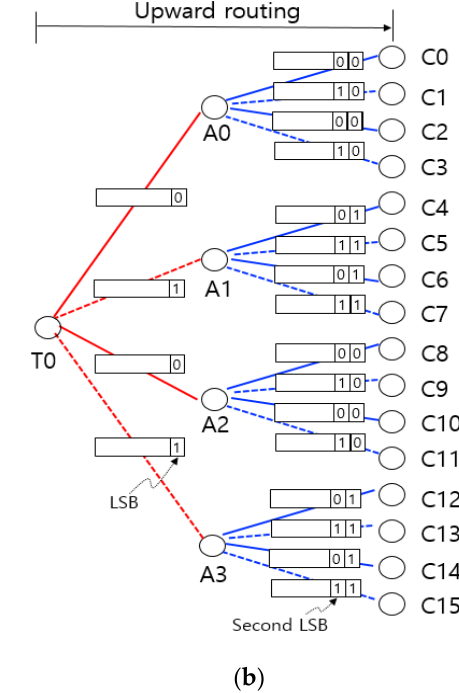
Figure 4. ( a ) Illustrations of destination address ranges associated with downlink ports of the core switch C15 and the aggregation Switch A3 in the fat-tree shown in Figure 2; and ( b ) an illustration of partitioning 16 shortest paths into four path groups and assigning path groups according to the least significant bits of the destination address.